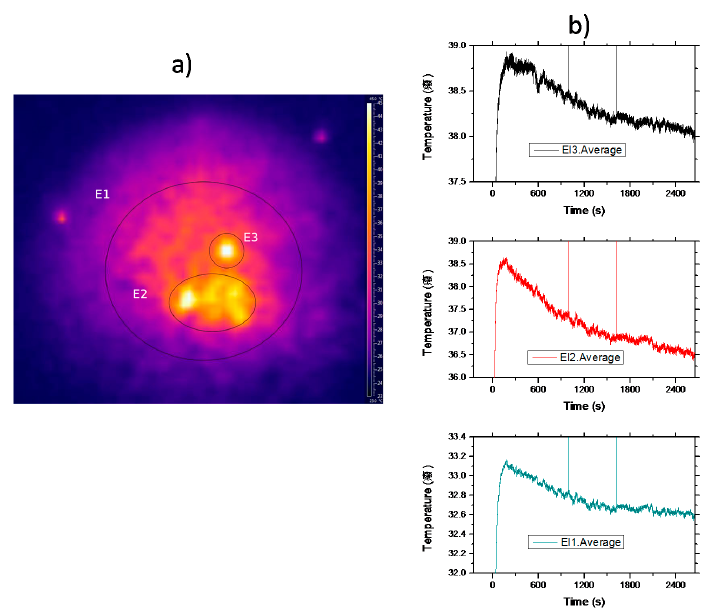
Figure 10. ( a ) FLIR camera video frame showing discrete thermal zones after pumping with 300 mW at 842 nm in a 2 mol% Er 3+ - doped La 2 O 2 S powder sample; ( b ) Average temperature as a function of time measured in the three shown zones in ( b ).